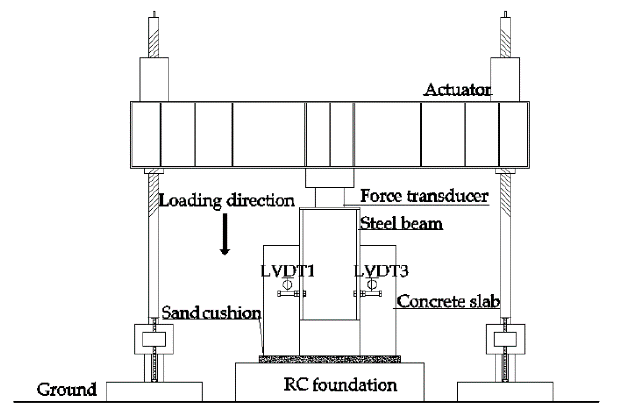
Figure 2. Push-off